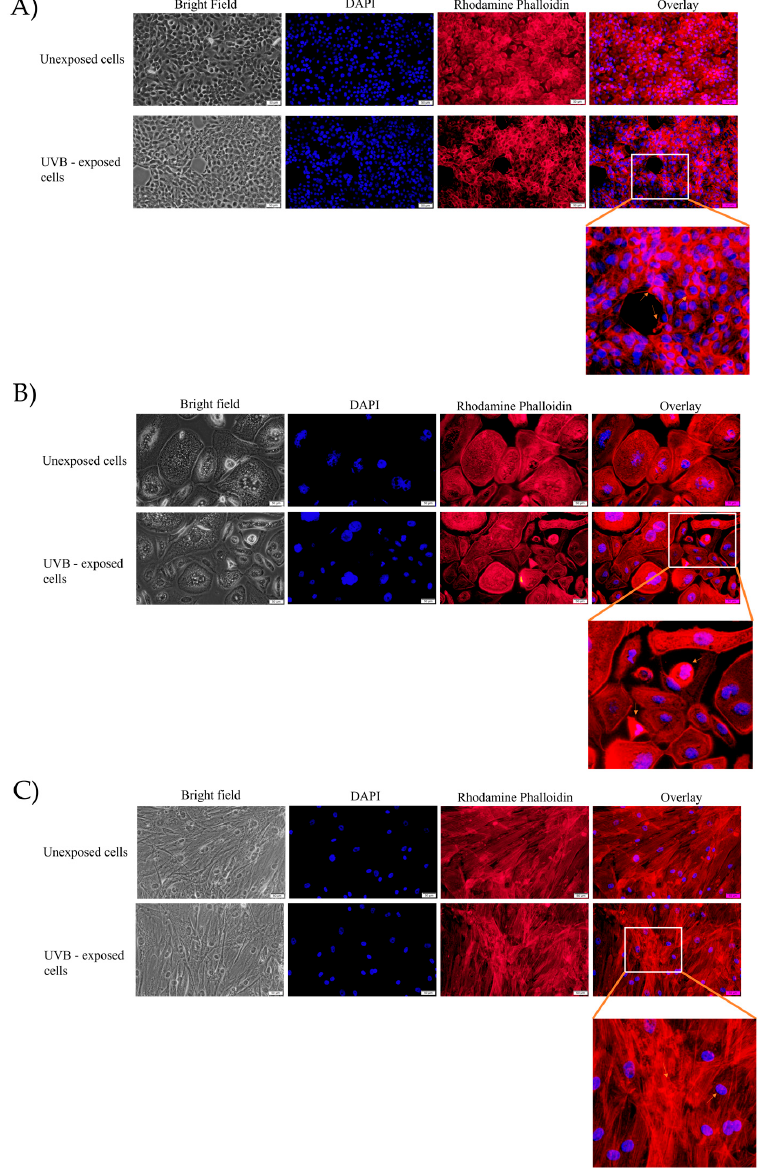
Figure 3. ( A ) Detroit-562 cells, ( B ) SCC4 cells, and ( C ) HGF cells visualized by fluorescence mi- croscopy after exposure to UVB 2.5 J/cm 2 . The impact of UVB radiation on the nuclei is shown by DAPI staining (blue) and, for the F-actin fibers, rhodamine phalloidin (red). The yellow arrows highlight the apoptotic-like changes. The scale bar indicates 50 µ